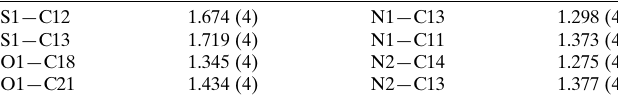
Table 2 Hydrogen-bond geometry (A˚ , (cid:2) ).